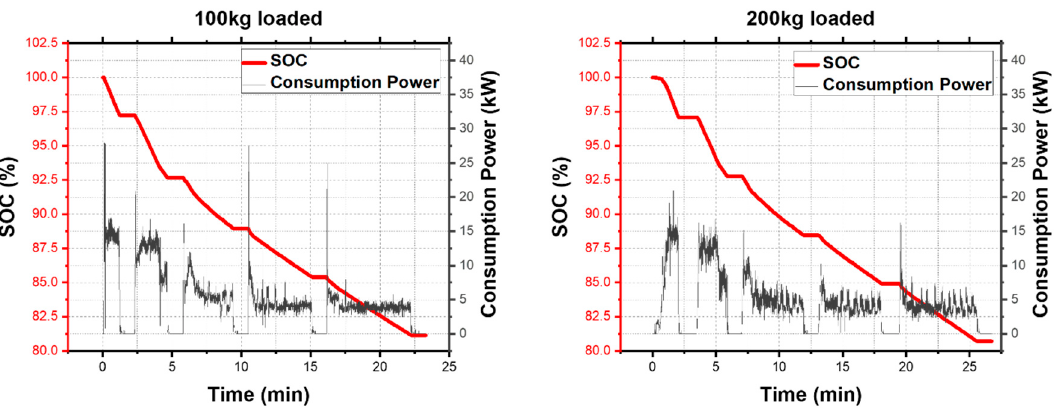
Figure 9. Power consumption trend based on loading.